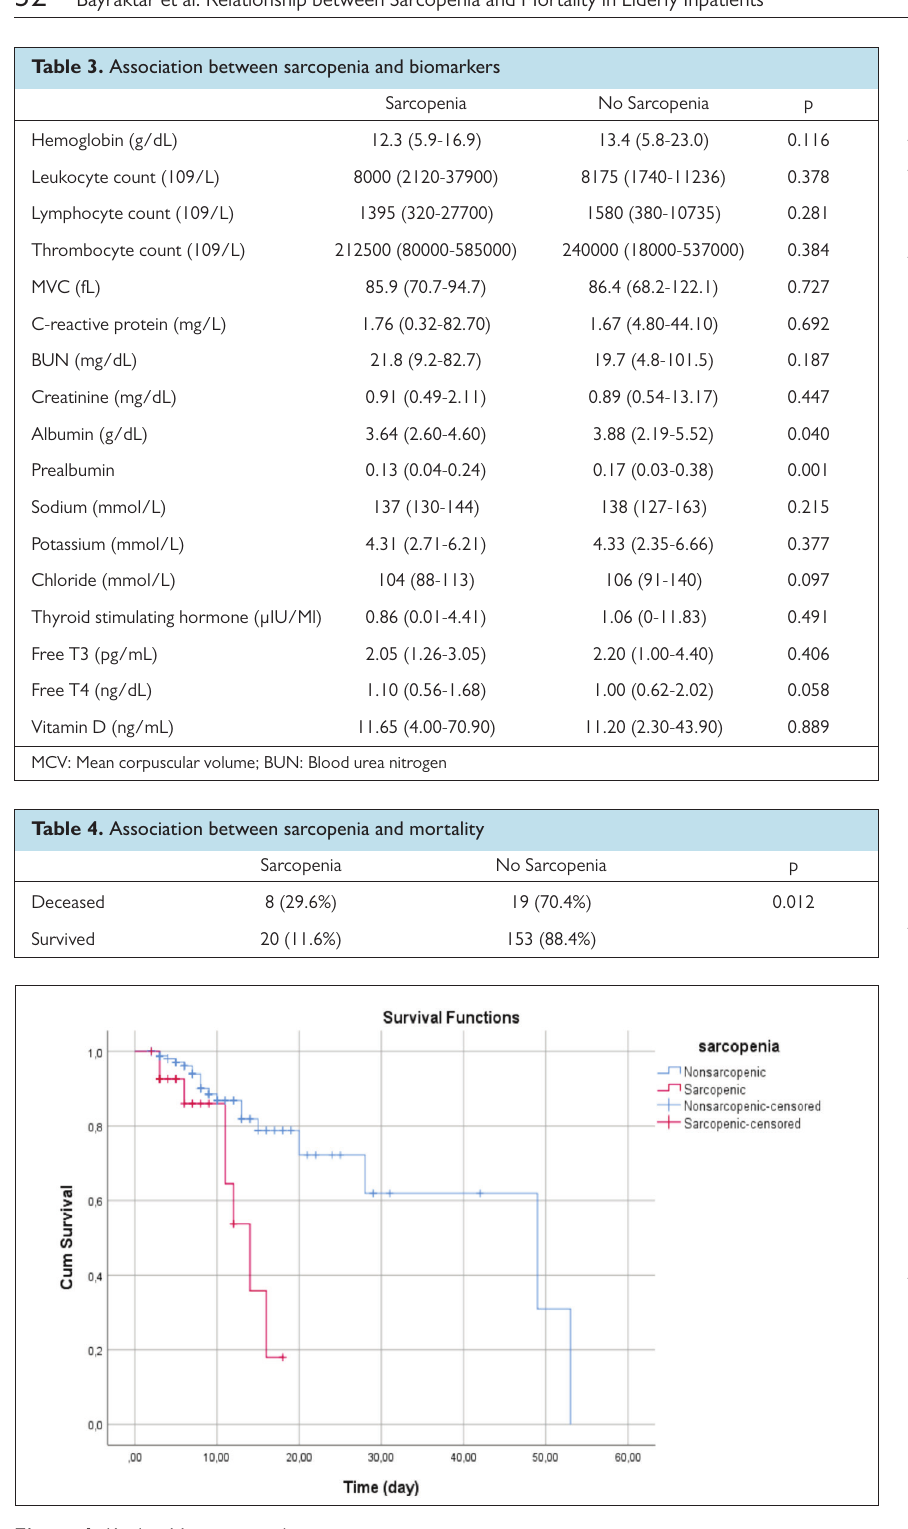
Figure 1. Kaplan-Meier survival curves.